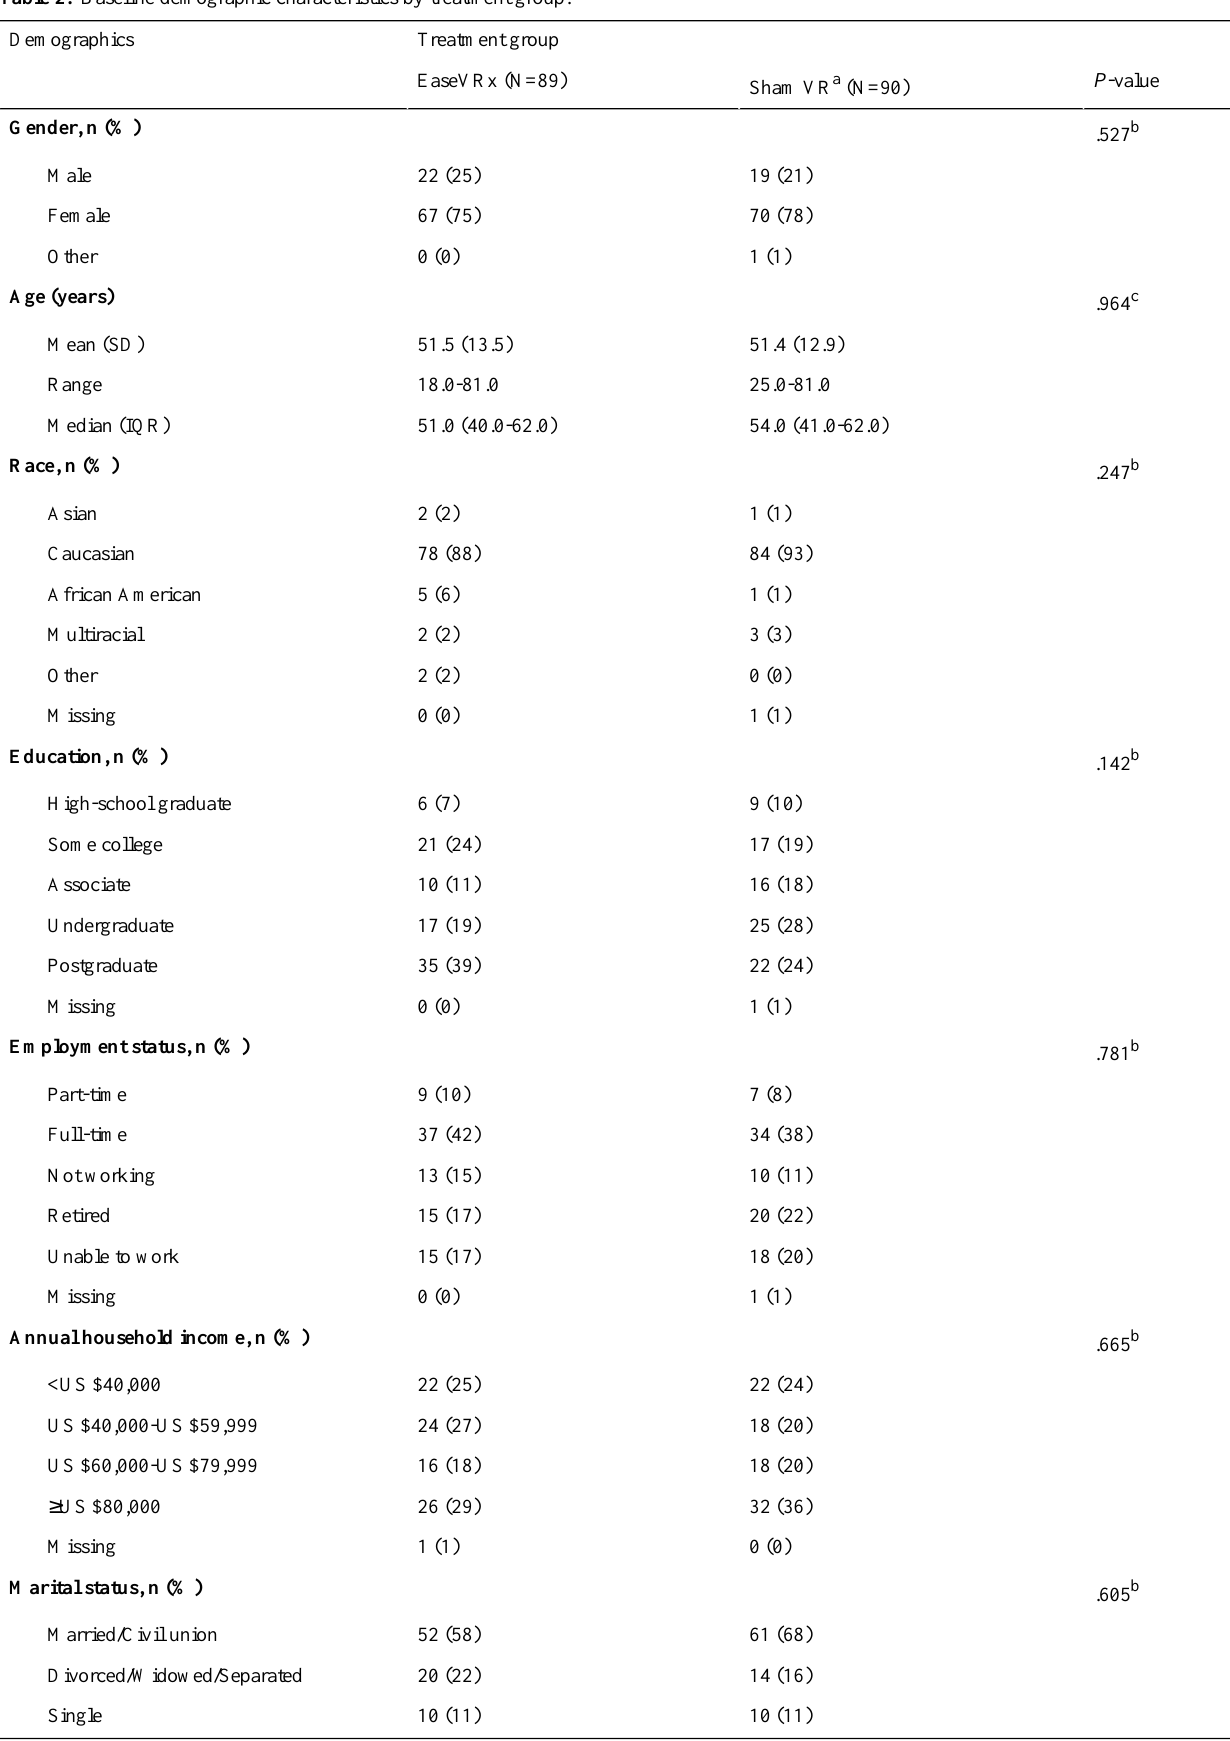
Table 2. Baseline demographic characteristics by treatment